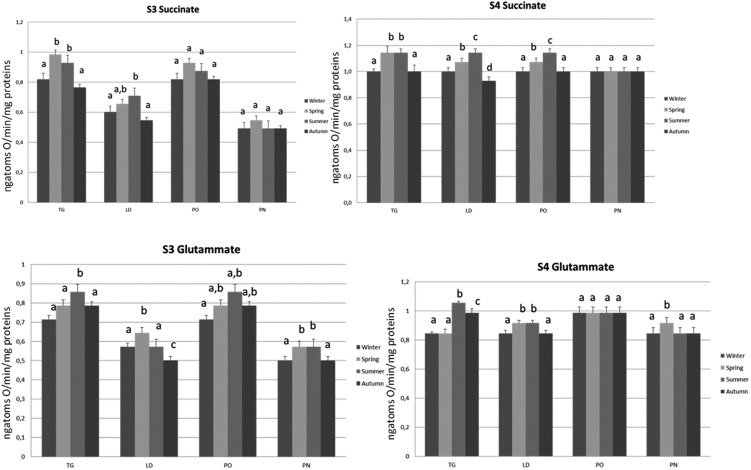
Mitochondrial respiration rates and oxidative stress of M. galloprovincialis collected at the different sites and periods. Different superscripted letters indicate statistically significant differences (P < 0.05).